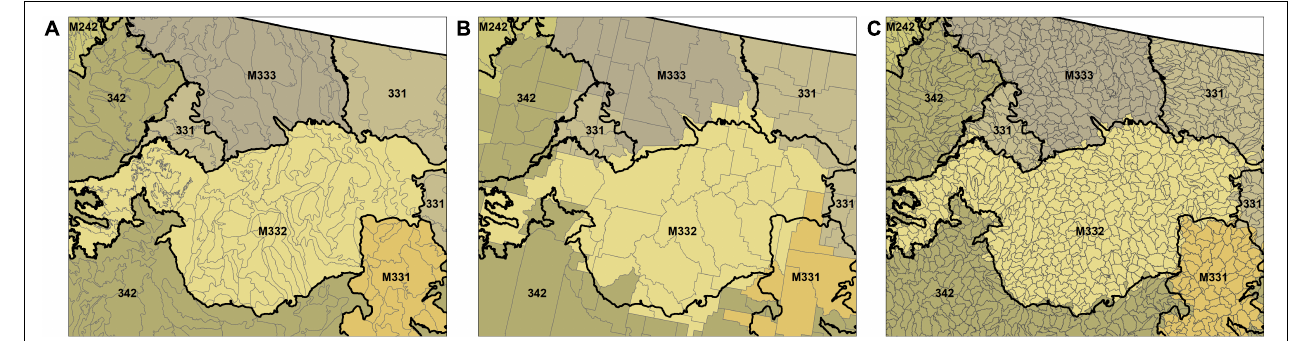
FIGURE 2 | Illustration of provincial modeling domain and the (A) ecosubsections, (B) counties, and (C) watersheds they contain. Domains are assigned to modeling domain based on plurality of occupancy.